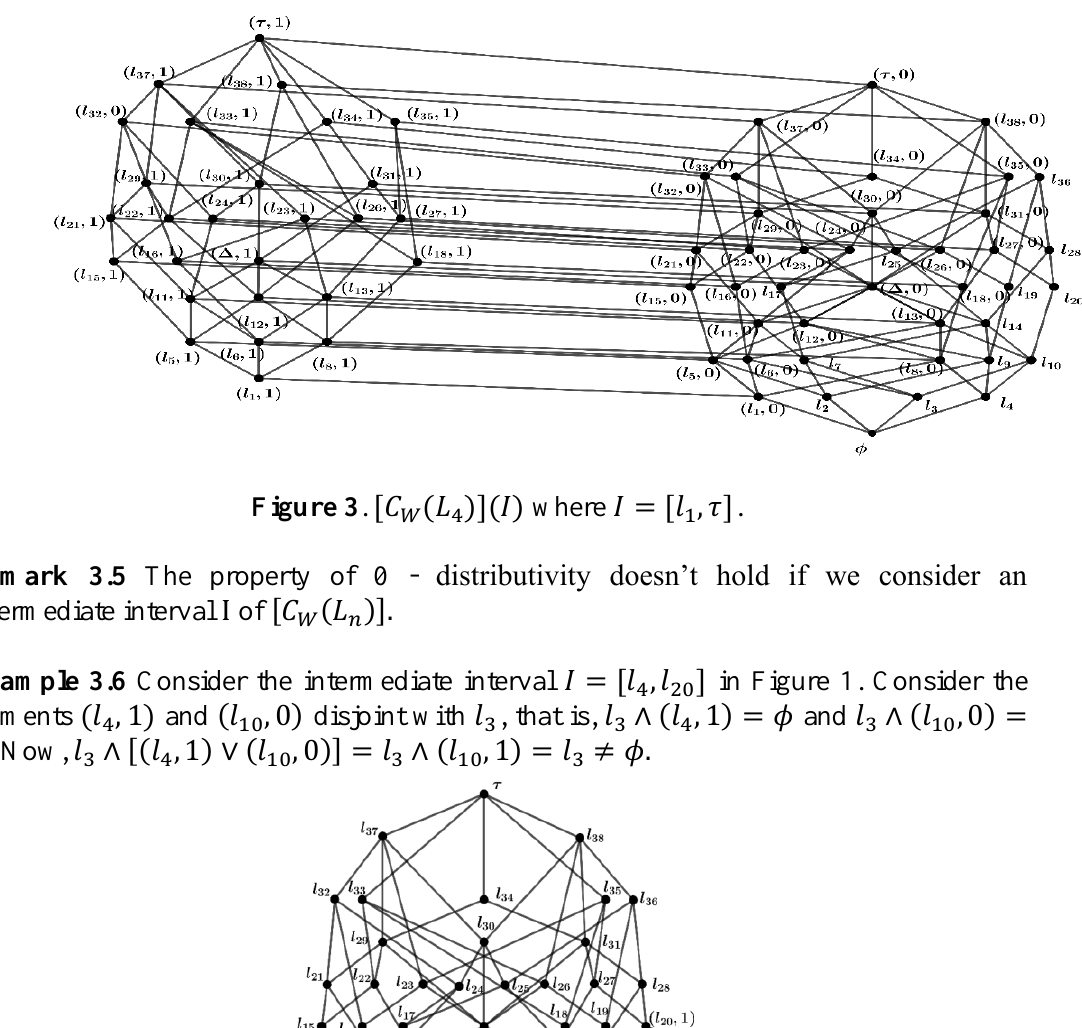
(𝐿 )[𝐼] where 𝐼 = [𝑙 𝑊 4